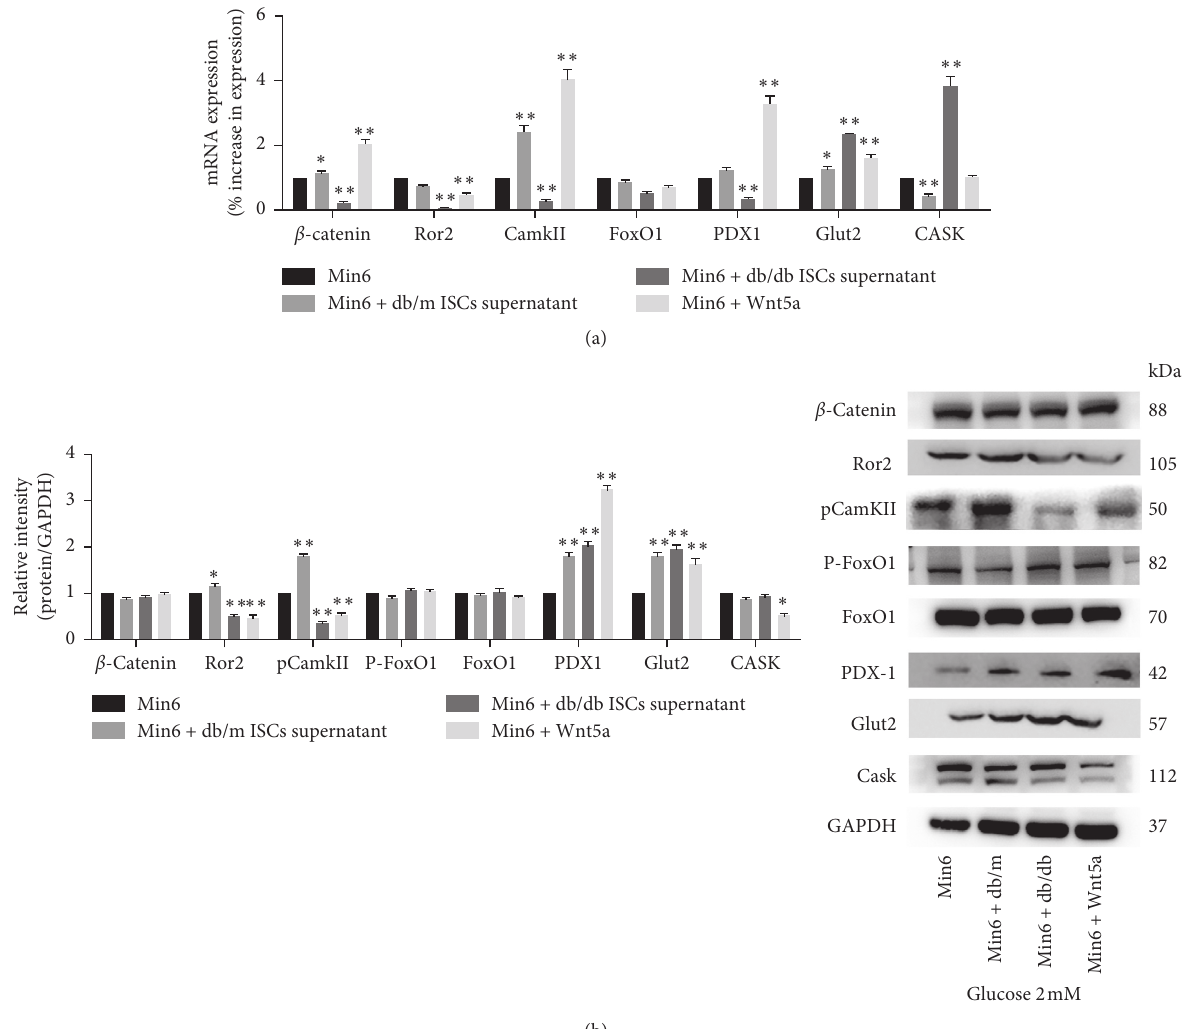
Figure 6: Intracellular mechanism of action of Wnt5a in the regulation of insulin secretion from Min6 cells. (a) GSIS was induced, and qRT- PCR analyses of Min6 cells alone, Min6 cells cultured with ISC supernatant, and Min6 cells cultured with exogenous Wnt5a were performed to measure β -catenin, Ror2, CamKII, FoxO1, PDX1, Glut2, and Cask mRNA level (2mM glucose conditions). ∗ p < 0 . 05 and ∗∗ p < 0 . 01 vs. Min6 cells cultured alone; (b) GSIS was induced, and β -catenin, Ror2, pCamKII, pFoxO1, FoxO1, PDX1, Glut2, and Cask protein levels were quantified by western blotting of Min6 cells cultured alone, Min6 cells cultured with ISC supernatant, and Min6 cells cultured with exogenous Wnt5a (2mM glucose conditions). ∗ p < 0 . 05 and ∗∗ p < 0 . 01 vs. Min6 cells cultured